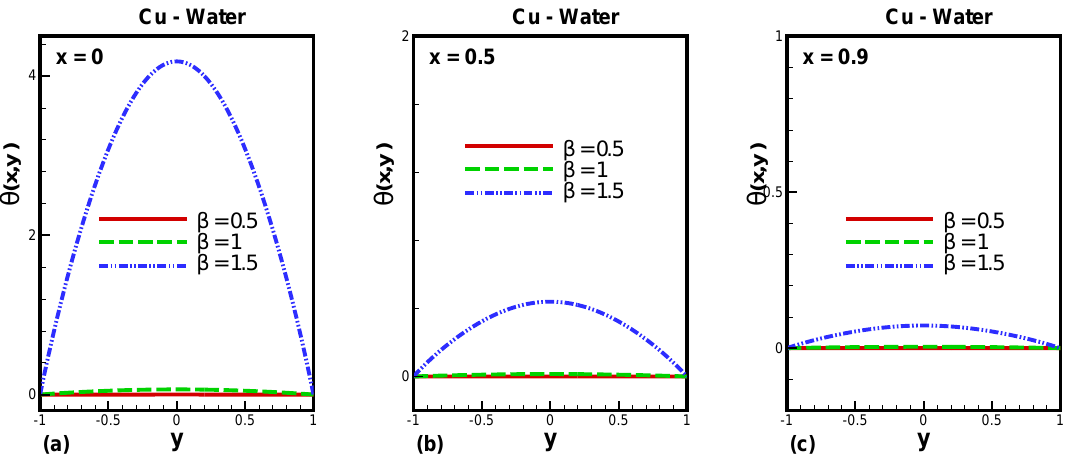
Figure 10. Effect of β on dimensionless temperature distribution at the ( a ) entrance, ( b ) middle, and ( c ) exit regions of the channel, when φ = 0.05, δ = 0.2, P e = 1, B r = 6, δ = 0.2, and γ =